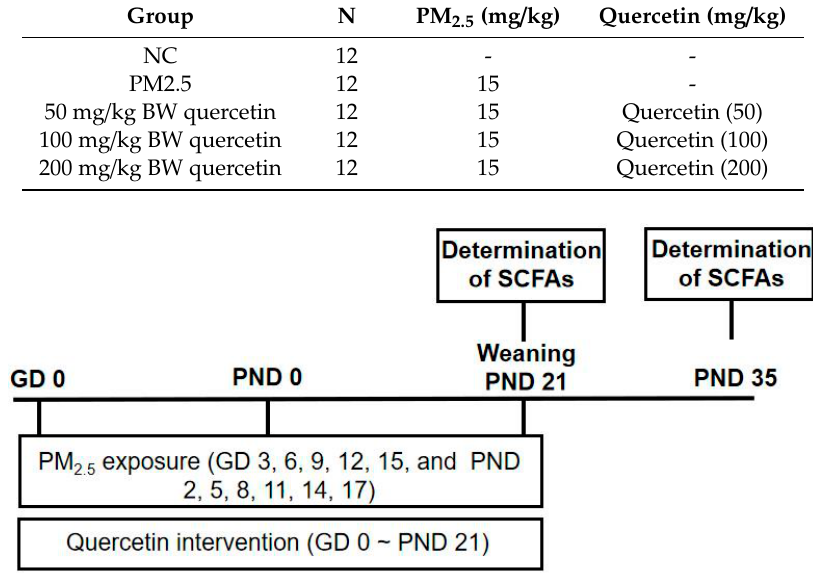
Table 1. Animal treatment.